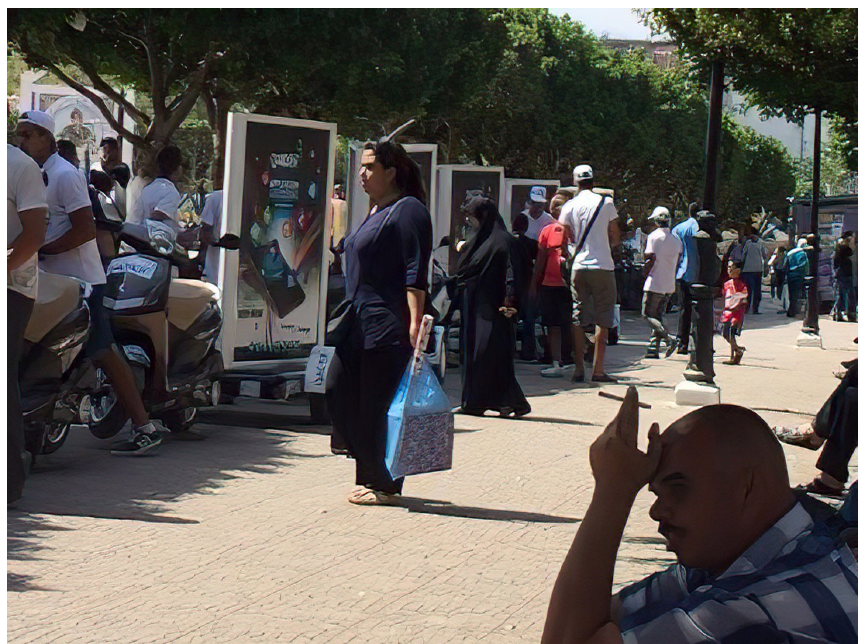
Fig. 4. Blida’s liberty Square, support for activities related to experiential marketing.